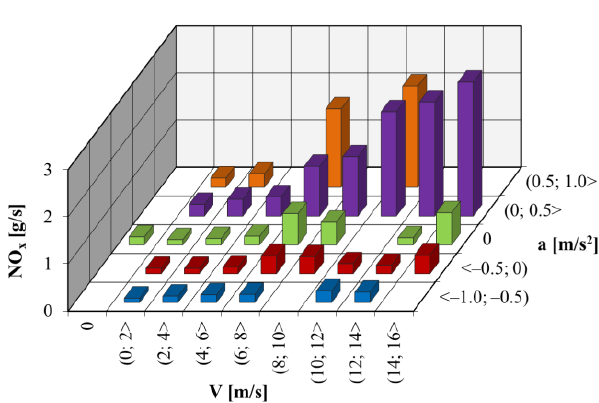
Fig. 13. NO x exhaust emission intensity of the tested vehicle in speed and acceleration intervals